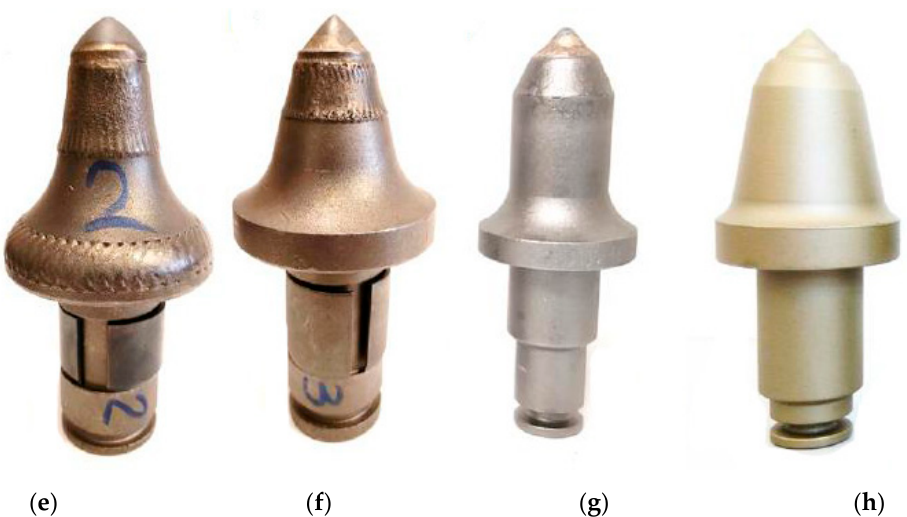
Figure 11. Types of conical picks for tests: ( a – c ) picks for roadheaders; ( d – f ) picks for shaft-boring roadheaders; ( g , h ) picks for longwall shearers.